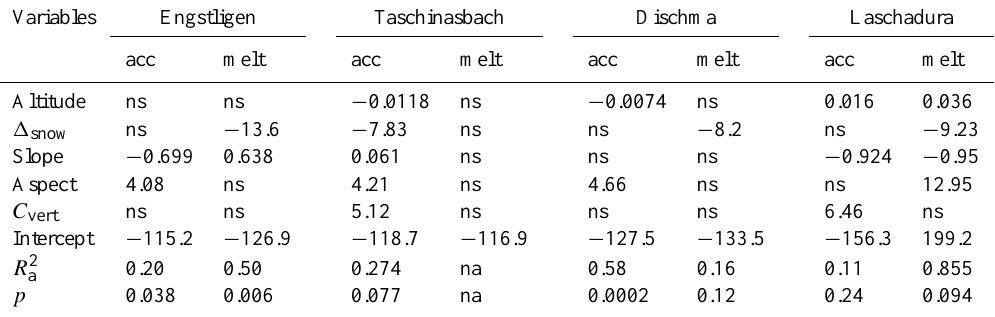
Table 3. Adjusted R 2 for computed regression equations, level of significance ( p value) and values of β -coefficients for the MLR model of each catchment separated into accumulation and melt period (ns=predictor variable not selected, na=not applicable).